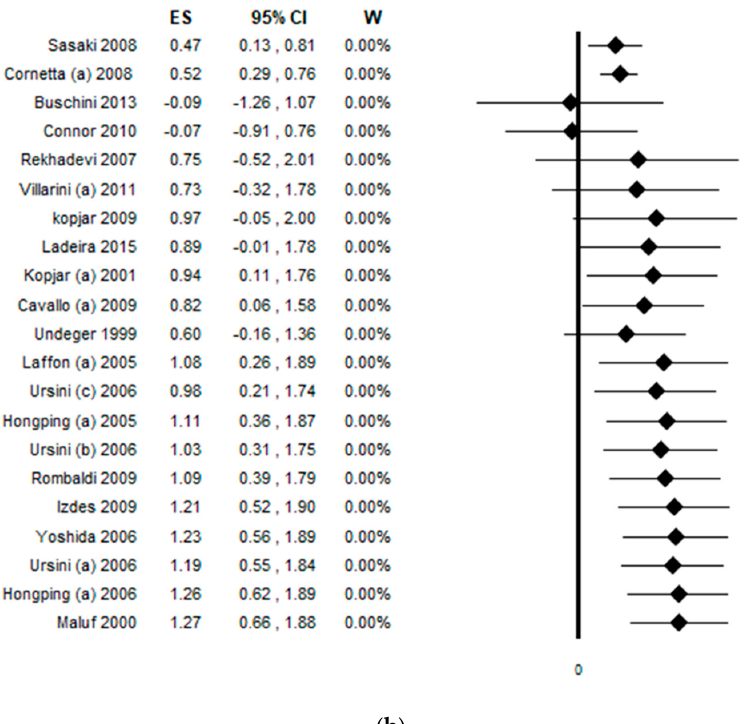
Figure 9. Cumulative analysis by ( a ) year of publication (descending order) and ( b ) effect size (ES) (from the smallest to the biggest) assessing the comet assay on lymphocytes cells among professionals occupationally exposed to antineoplastic drugs (ANDs).